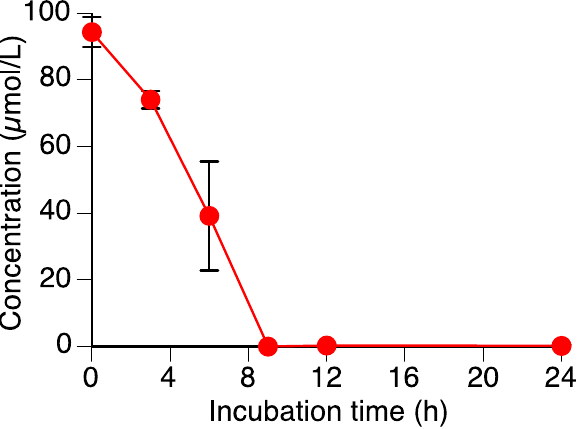
Figure 2. Time-dependent decrease in sakuranetin ( 1 ) content in the Rhizoctonia solani suspension culture. Values are reported as the mean ± SD ( n = 3).